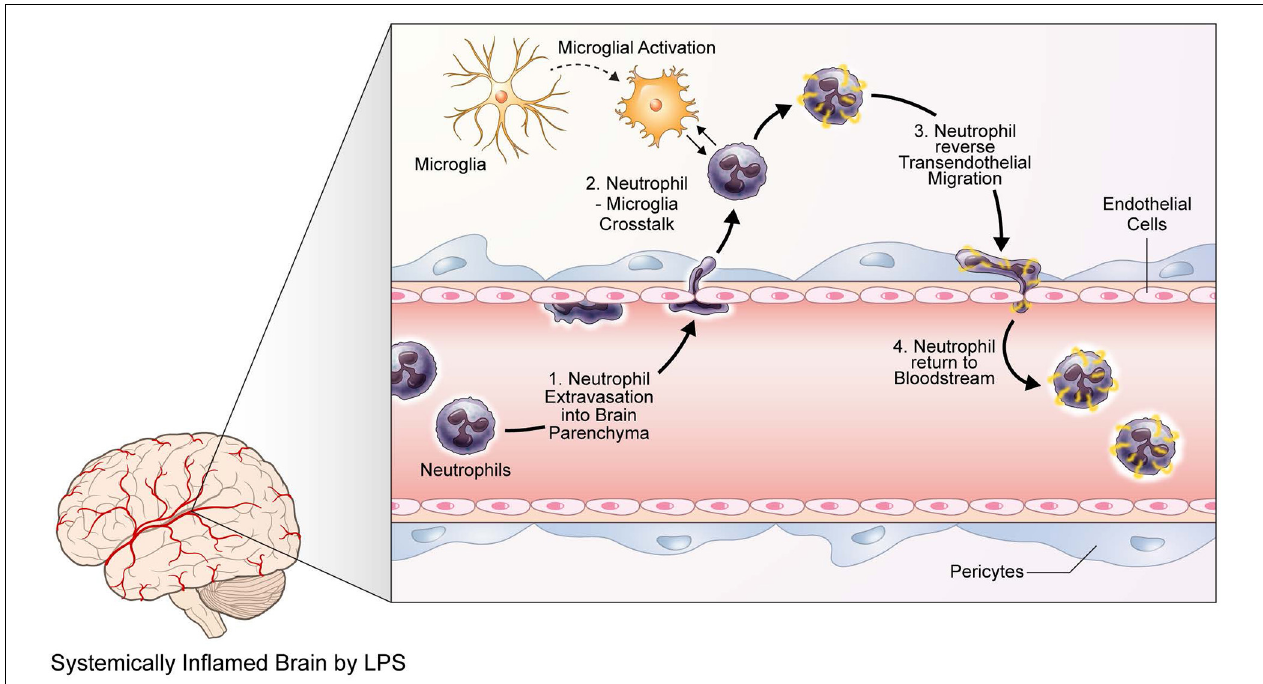
FIGURE 5 | Neutrophils and microglia exhibit various behavioral and phenotypical responses to LPS-induced neuroinflammation. A graphic illustration describing the responses of neutrophils and microglia to LPS-induced neuroinflammation, as identified via two-photon microscopy. Upon LPS injection and the following neuroinflammatory situations, neutrophils first respond by extravasating into the brain parenchyma. Meanwhile, microglia are activated and thus undergo morphological changes, such as enlargement of cell bodies and shortening of processes. Such activated microglia interact with infiltrated neutrophils, possibly causing molecular modifications on the neutrophils; thereafter, neutrophils engage in reverse transendothelial migration, returning to the